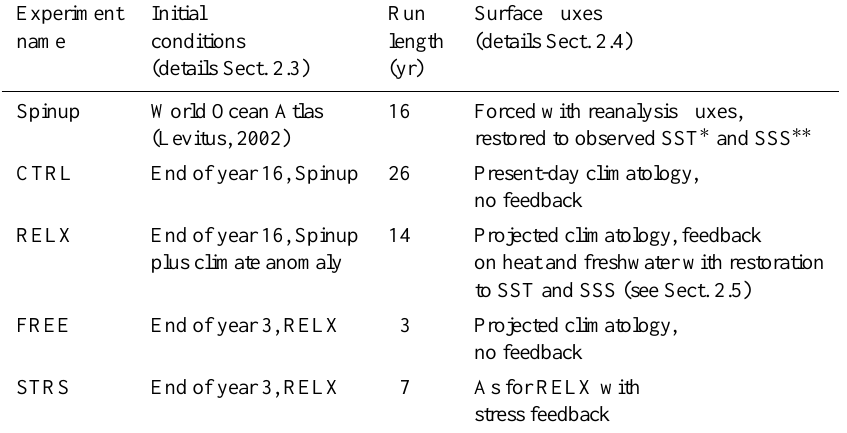
Table 1. Details of ODM experiments presented.